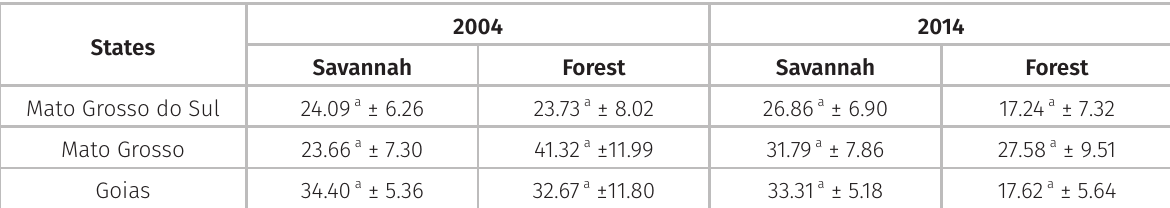
Table I. Mean percentages of savannah and forest areas for the settlements of the states in the Midwest region in 2004 and 2014, with the standard error for each